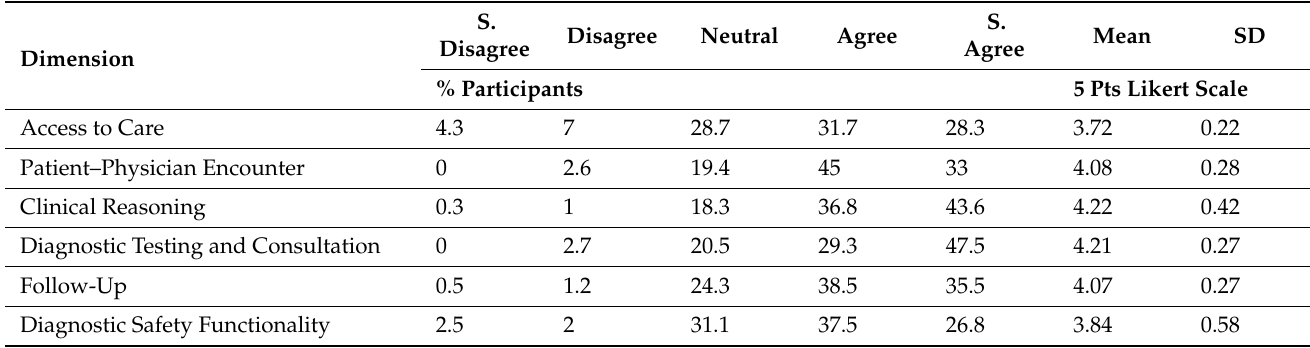
Table 4. Frequency of responses on the dimensions of the study model.